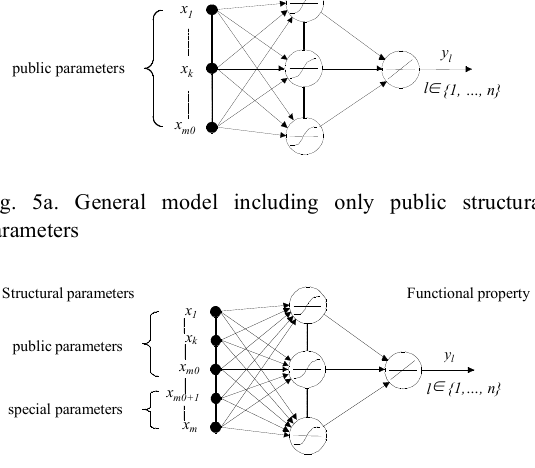
Fig. 5b. Special model including public and special structural